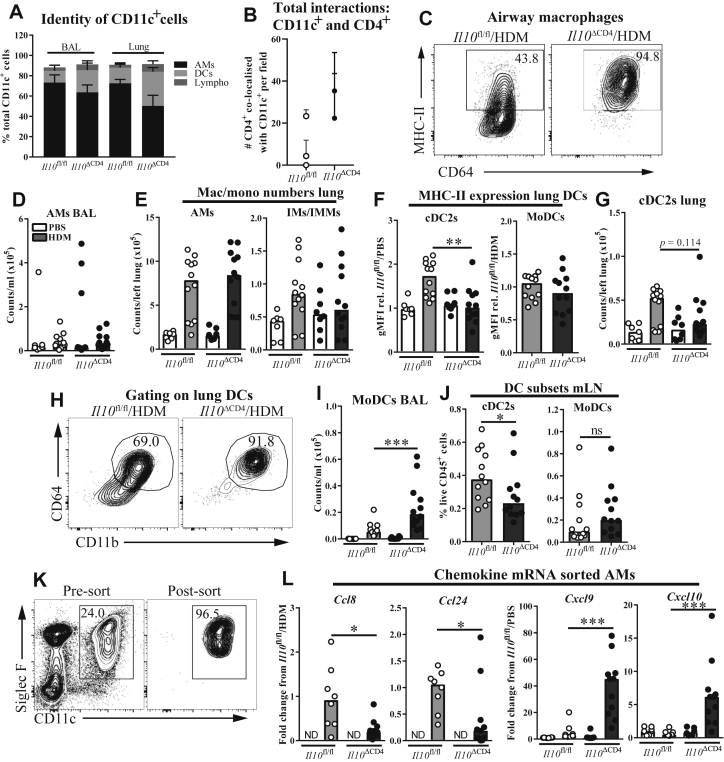
Myeloid cells in HDM-treated T cell–specific IL-10 knockout mice. A, Percentages of total live CD11c+ cells with the AM (lineage-negative CD11c+ Siglec-F+ CD64+), DC (lineage/Ly6G/Siglec-F− CD11c+ MHC class II+ CD11b+ or CD103+), or lymphocyte (Lympho; lineage-positive forward scatter/side scatter low) phenotype, as determined by using flow cytometry. B, Numbers of CD4+ cells within 10 μm of a CD11c+ cell in precision-cut lung slices. C-K, Flow cytometric data. Fig E5, C, Representative plots showing MHC class II expression by AMs. Fig E5, D and E, Numbers of AMs in BAL fluid and lung tissue and IMs/IMMs in lung tissue. Fig E5, F, Fold differences (from indicated group) in geometric mean fluorescence intensity of MHC class II staining on cDC2s and moDCs in lung tissue. Fig E5, G, Total cDC2 numbers in lung tissue. Fig E5, H, Plots showing moDCs (gated) among total DCs in lung tissue. Fig E5, I, Total moDC numbers in BAL fluid. Fig E5, J, cDC2s and moDCs as percentages of total CD45+ leukocytes in mLNs. Fig E5, K, Representative plots showing total cells from BAL fluid before and after AM sorting. L, Fold changes in mRNA expression of chemokines summarized in Fig 5, K, in AMs sorted by means of fluorescence-activated cell sorting. Fig E5, A, shows median percentages ± interquartile ranges pooled from 2 experiments (n = 7-12 per group). Points in Fig 5, B, show means ± SDs of 3 equally sized fields from each of 2 to 3 mice per group. All other data show medians and individual replicates and are pooled from 2 to 3 experiments (n = 7-12 per group). *P < .05, **P < .01, and ***P < .001. ND, Not detected; ns, not significant.